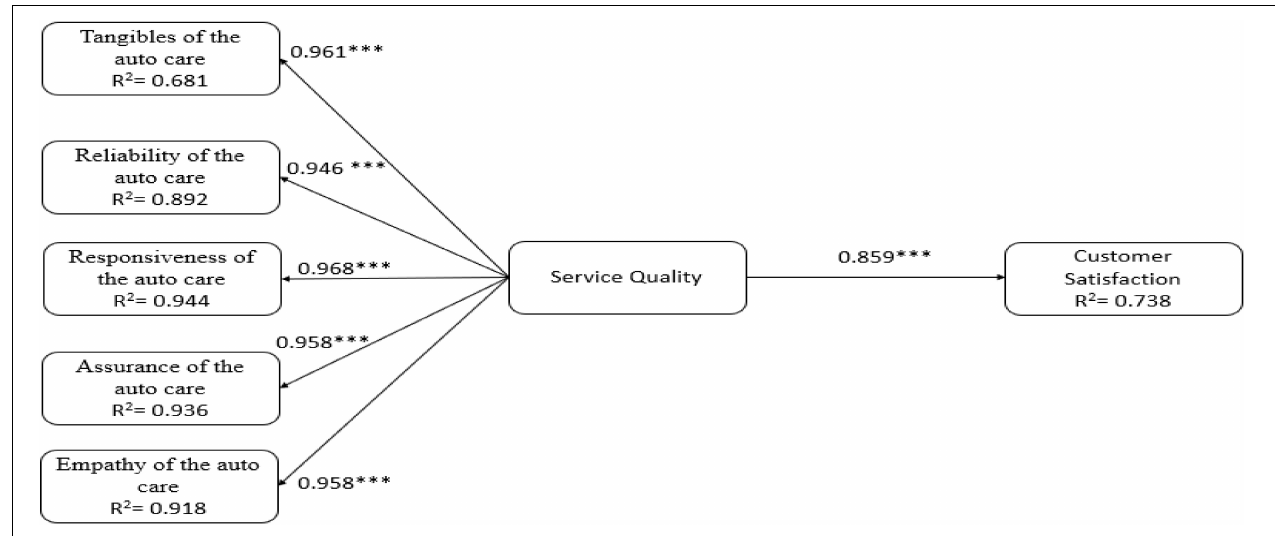
FIGURE 1 | Results of the research model tests. ∗∗∗ p <